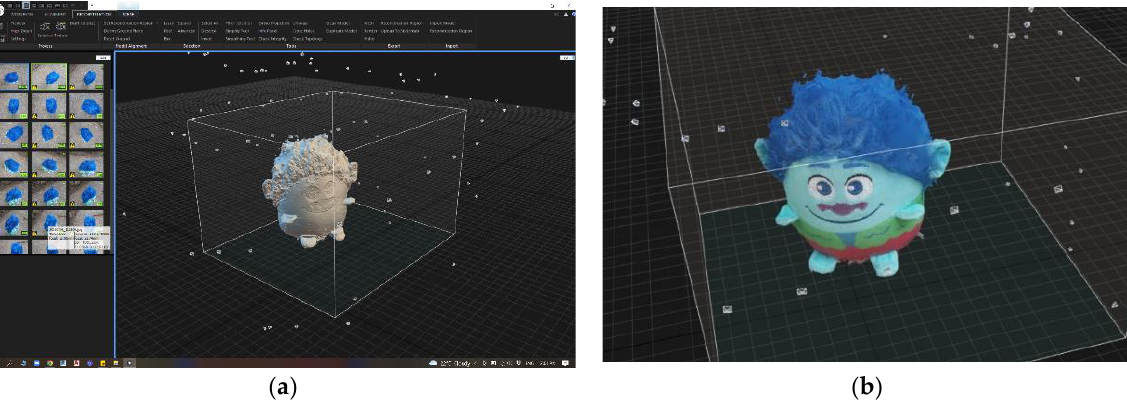
Figure 3. Second attempts outdoor photography with random environment of plush toy ( a ) Model; ( b ) Real toy.